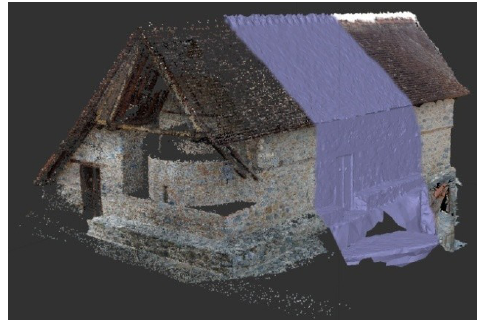
Figure 5. 3D reconstruction of Archangelos Michael church using an image-based technique. From left to right: point cloud, 3D mesh, textured 3D mesh.